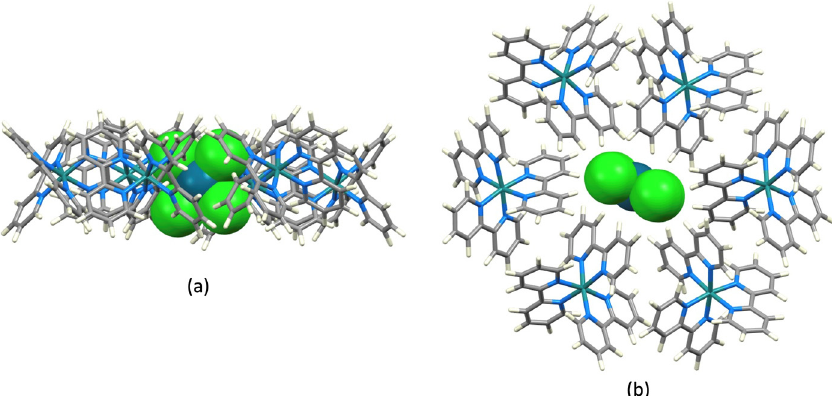
Figure 12. Structure Type I motif in [Ru(bpy) 3 ] 2 [PdCl 4 ][Pd(ox) 2 ] . 11H 2 O (CSD refcode TEXDAC) [81]. ( a ) One hexagonal motif within one sheet viewed down the crystallographic b -axis, and ( b ) the same unit viewed from above showing the bpy H3 and H3 (cid:48) atoms directed towards the [PdCl 4 ] 2– ion. Table 6. Metrics for Type I and II motifs in salts containing [MCl 4 ] 2– anions. REFCODE X Space Group